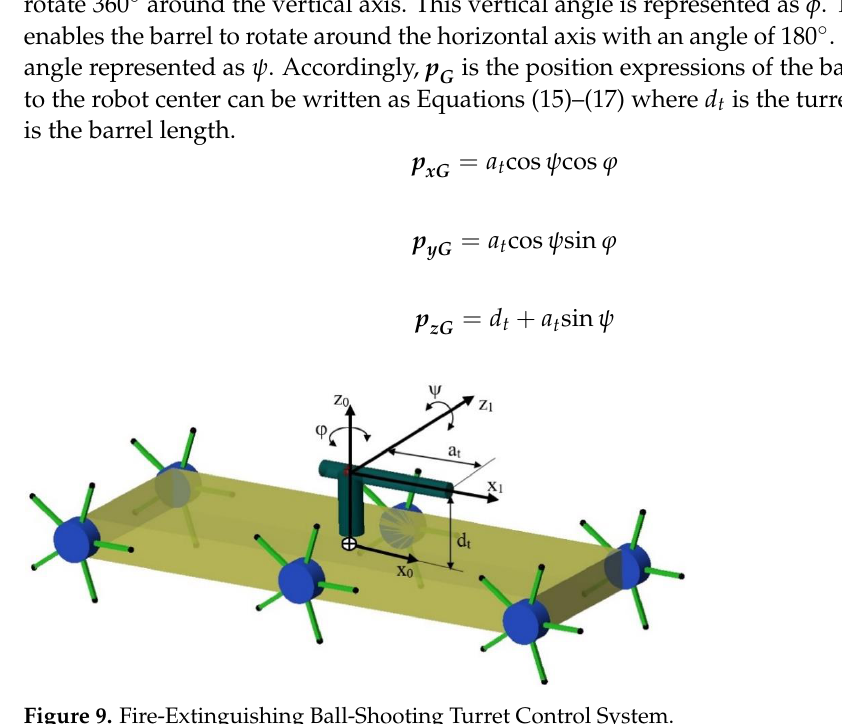
rotate 360° around the vertical axis. This vertical angle is represented as  . The second axis enables the barrel to rotate around the horizontal axis with an angle of 180°. This horizon-